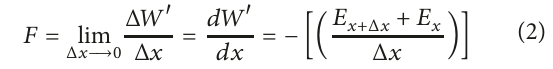
Figure 2: Electromagnet structure. (1) Coil; (2) iron core; (3) armature; (4) air gap.